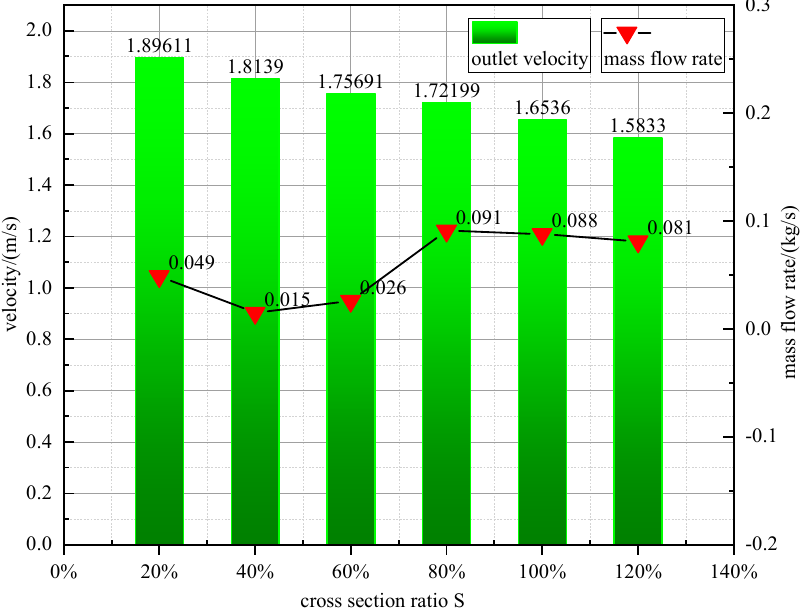
Figure 9. Variation in air velocity and air mass flow rate at the outlet of a wall-mounted solar chimney for different S-values.